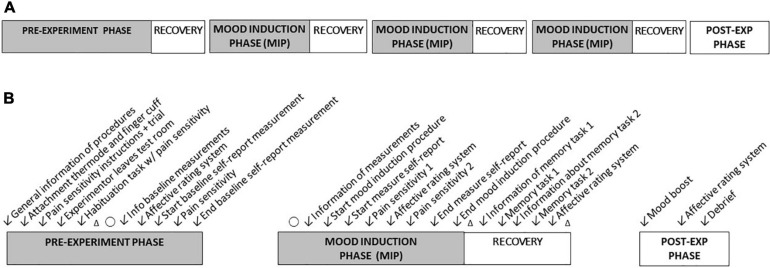
The experimental procedures. (A) The general flow of study phases. The order of mood inductions was randomized. (B) The order of procedures within study phases. Δ = 30 s rest period, O = 70 s rest period.